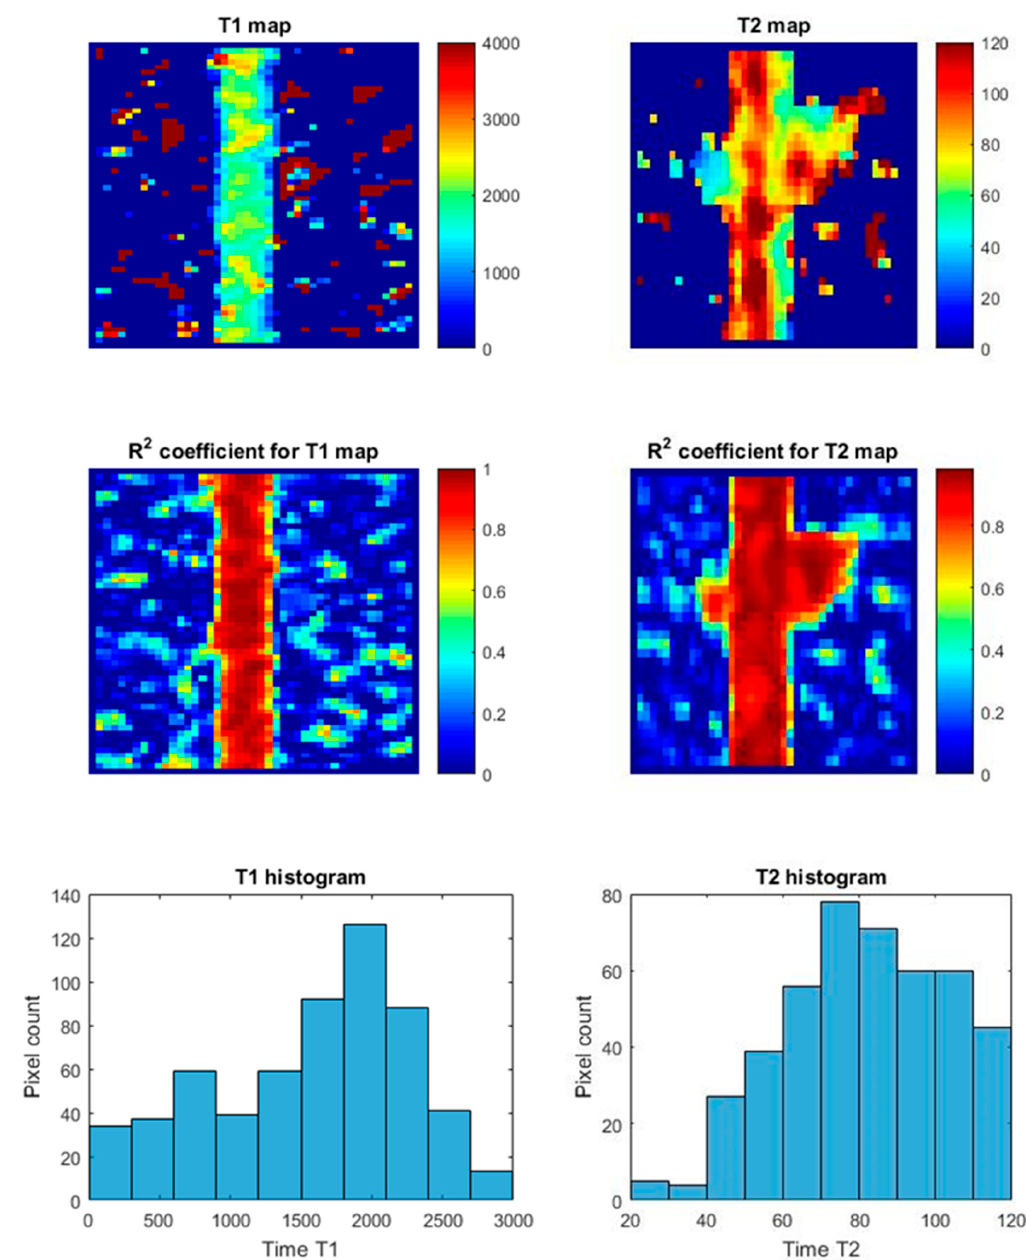
Figure 14. Maps of T 1 and T 2 relaxation times for the CRL-2310 bioreactor +5 Thioether cross-linked dendrimer conjugate Trastuzumab derivative in the bioreactor along with R 2 coefficient and histograms.